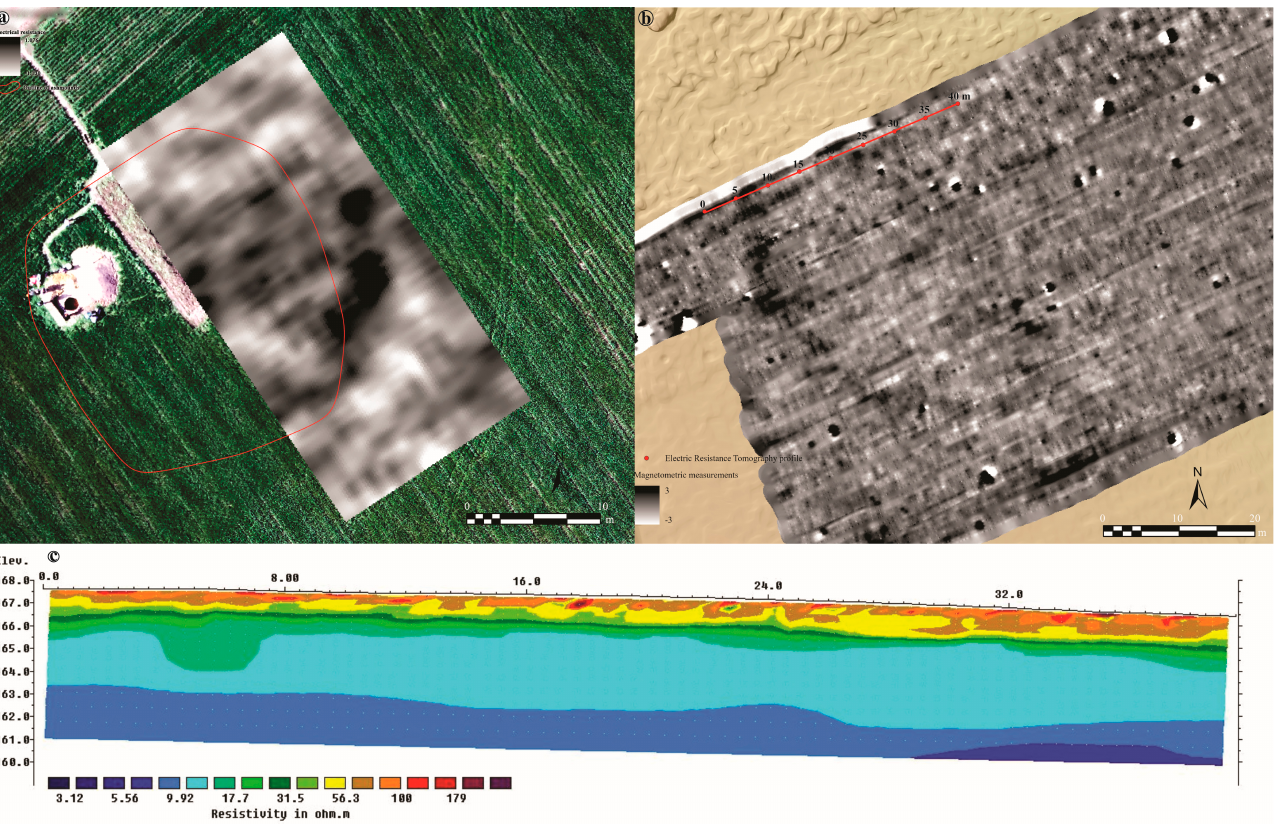
Figure 14. Results of geoelectric measurements: ( a ) Electrical Resistance map from Coarnele Caprei– Aramei Hill I (Ia ș i County); ( b ) the location of the ERT profile from B ă deni– Moara de Vânt Hill (Ia ș i Aramei Hill I (Ias i County); ( b ) the location of the ERT profile from B ă deni– Moara de V â nt Hill (Ias , County); ( c ) ERT profile no. 1 from B ă deni– Moara de Vânt Hill (Ia ș i County). County); ( c ) ERT profile no. 1 from B ă deni– Moara de V â nt Hill (Ias